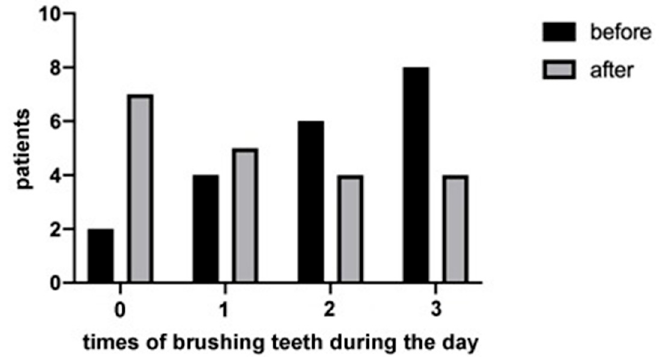
Figure 1. The graphic represents the times the patients used to brush their teeth before and after hospitalization. No statistical significance ( p = 0.20) was shown between these two time points of the study.